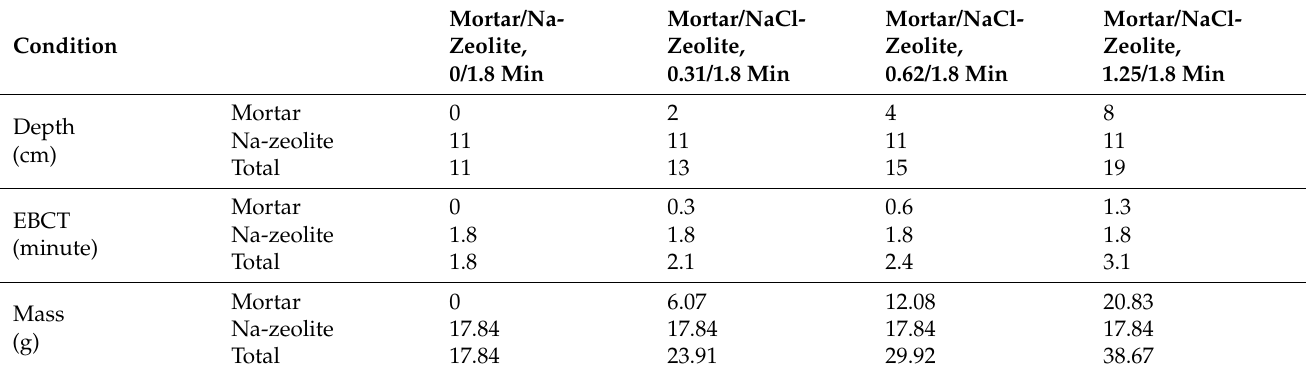
Table 2. Experimental conditions of mortar/Na-zeolite dual media according to